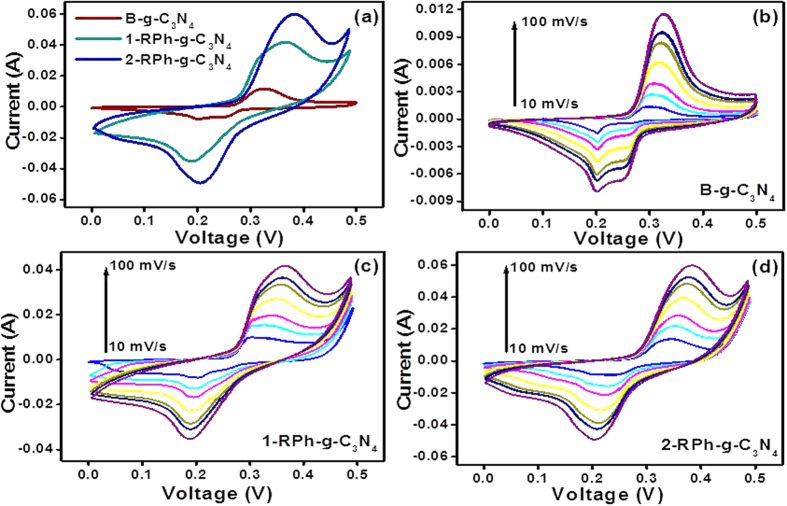
(a) Comparative cyclic voltammogram of B-g-C3N4, 1-RPh-g-C3N4, and 2-RPh-g-C3N4 at a scan rate of 100 mV s−1, (b) cyclic voltammogram of B-g-C3N4 at a scan rate of 10–100 mV s−1, (c) cyclic voltammogram of 1-RPh-g-C3N4 at a scan rate of 10–100 mV s−1, and (d) cyclic voltammogram of 2-RPh-g-C3N4 at a scan rate of 10–100 mV s−1.